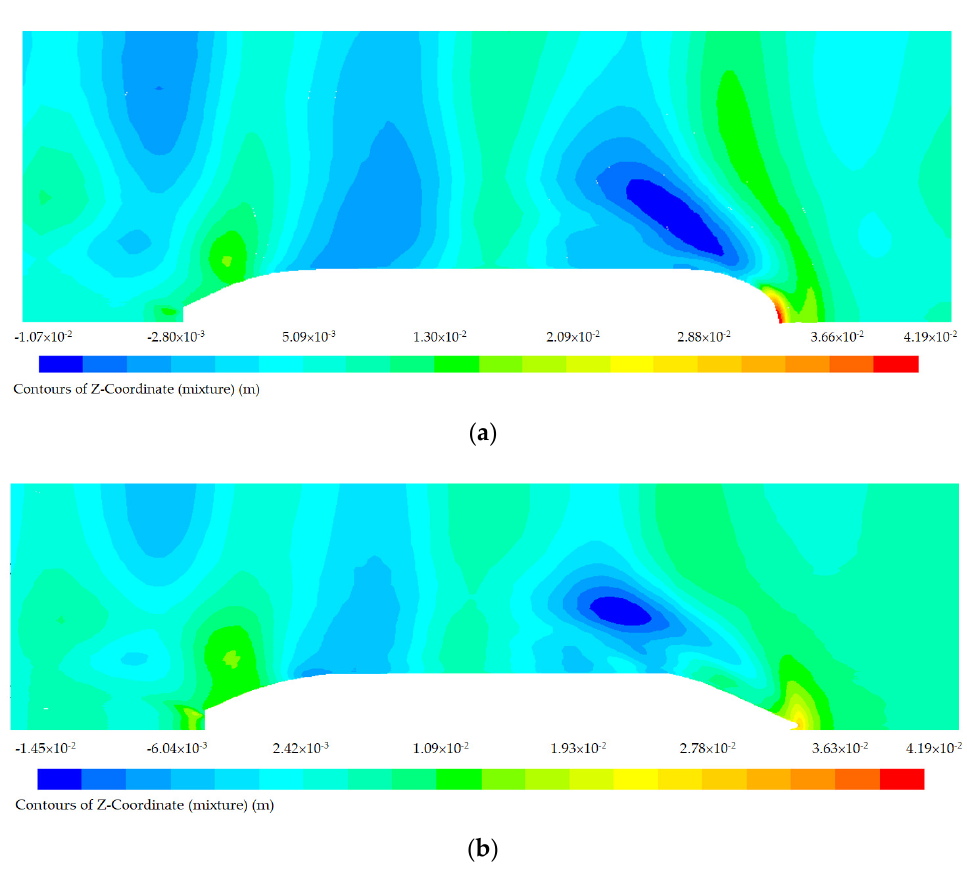
Figure 9. Simulated wave patterns at the free surface of the ships at F n = 0.163 with regular head waves. ( a ) The original model; ( b ) the new model with a bulbous bow.